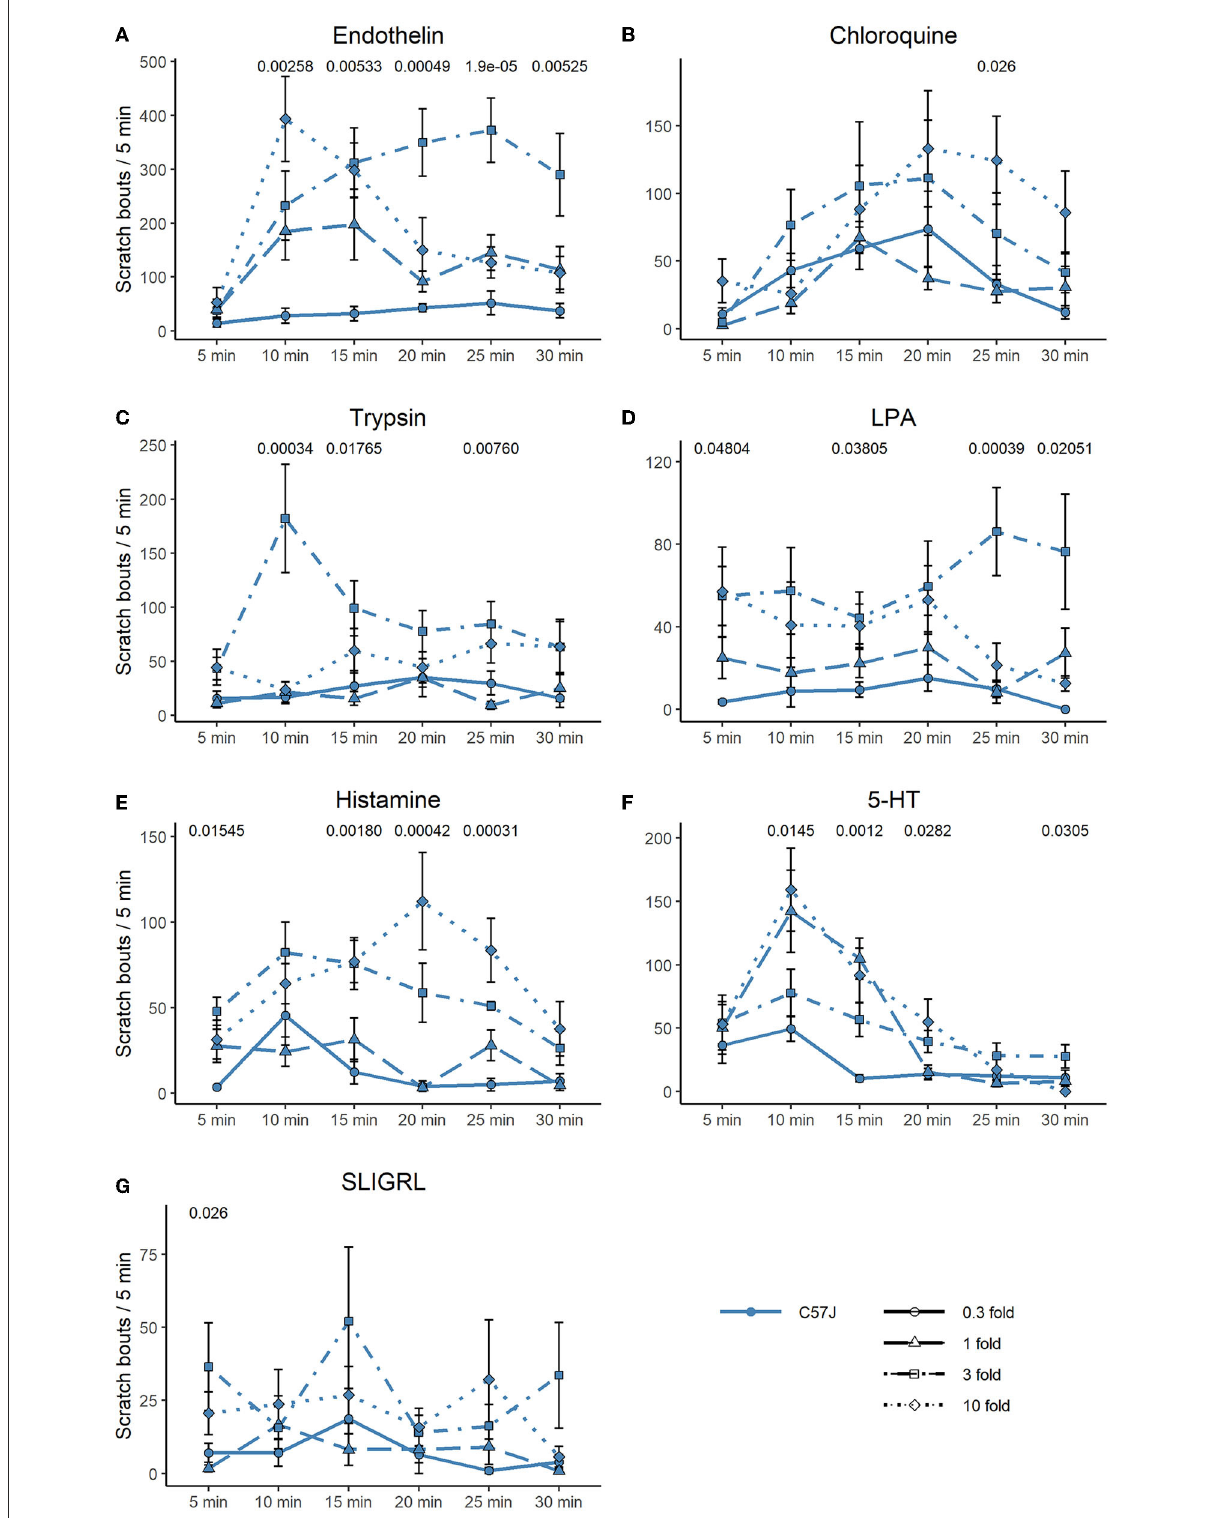
FIGURE4 Time-course of scratching bouts in C57. Each data point represents the mean ± SEM of scratch bouts in bins of 5 minutes in response to injection of (A) endothelin, (B) chloroquine, (C) trypsin, (D) LPA, (E) histamine, (F) 5-HT, and (G) SLIGRL into the nape of the neck. Four different concentrations were tested. P-values are indicated at the top of each panel and result from a repeated measures ANOVA. The different concentrations are discerned by shape and line type (0.3-fold = circle, solid line; one-fold = triangle, long dashed line; three-fold = square, dot dashed line; 10-fold = diamond, dotted